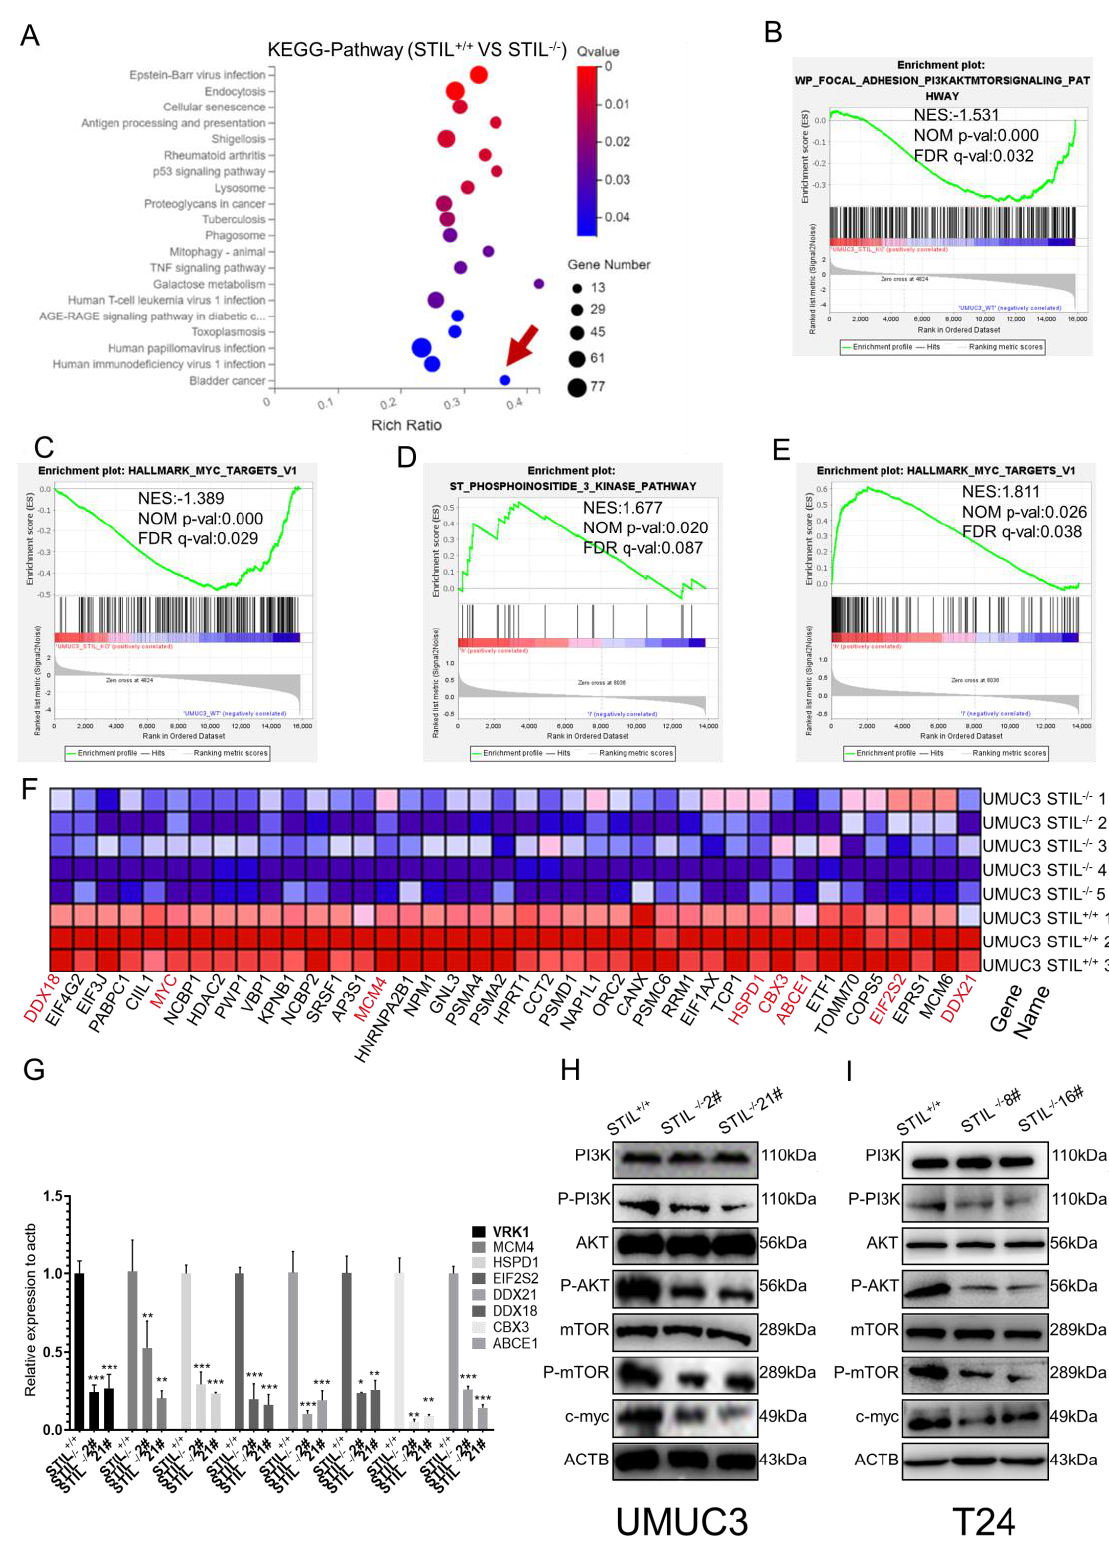
Figure 6. STIL knockout down-regulated the PI3K/AKT/mTOR/c-myc signaling pathway. ( A ) The RNA-seq analysis of STIL knockout and wild-type cells: we used KEGG pathway enrichment analysis in STIL +/+ and STIL − / − BC cells. GSEA identified ( B ) PI3K/AKT/mTOR pathway-related gene